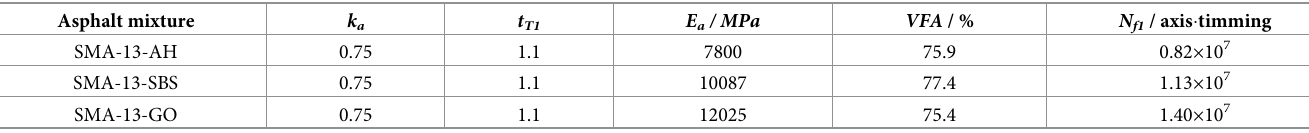
Table 10. High and low temperature performance indices of 3 asphalt